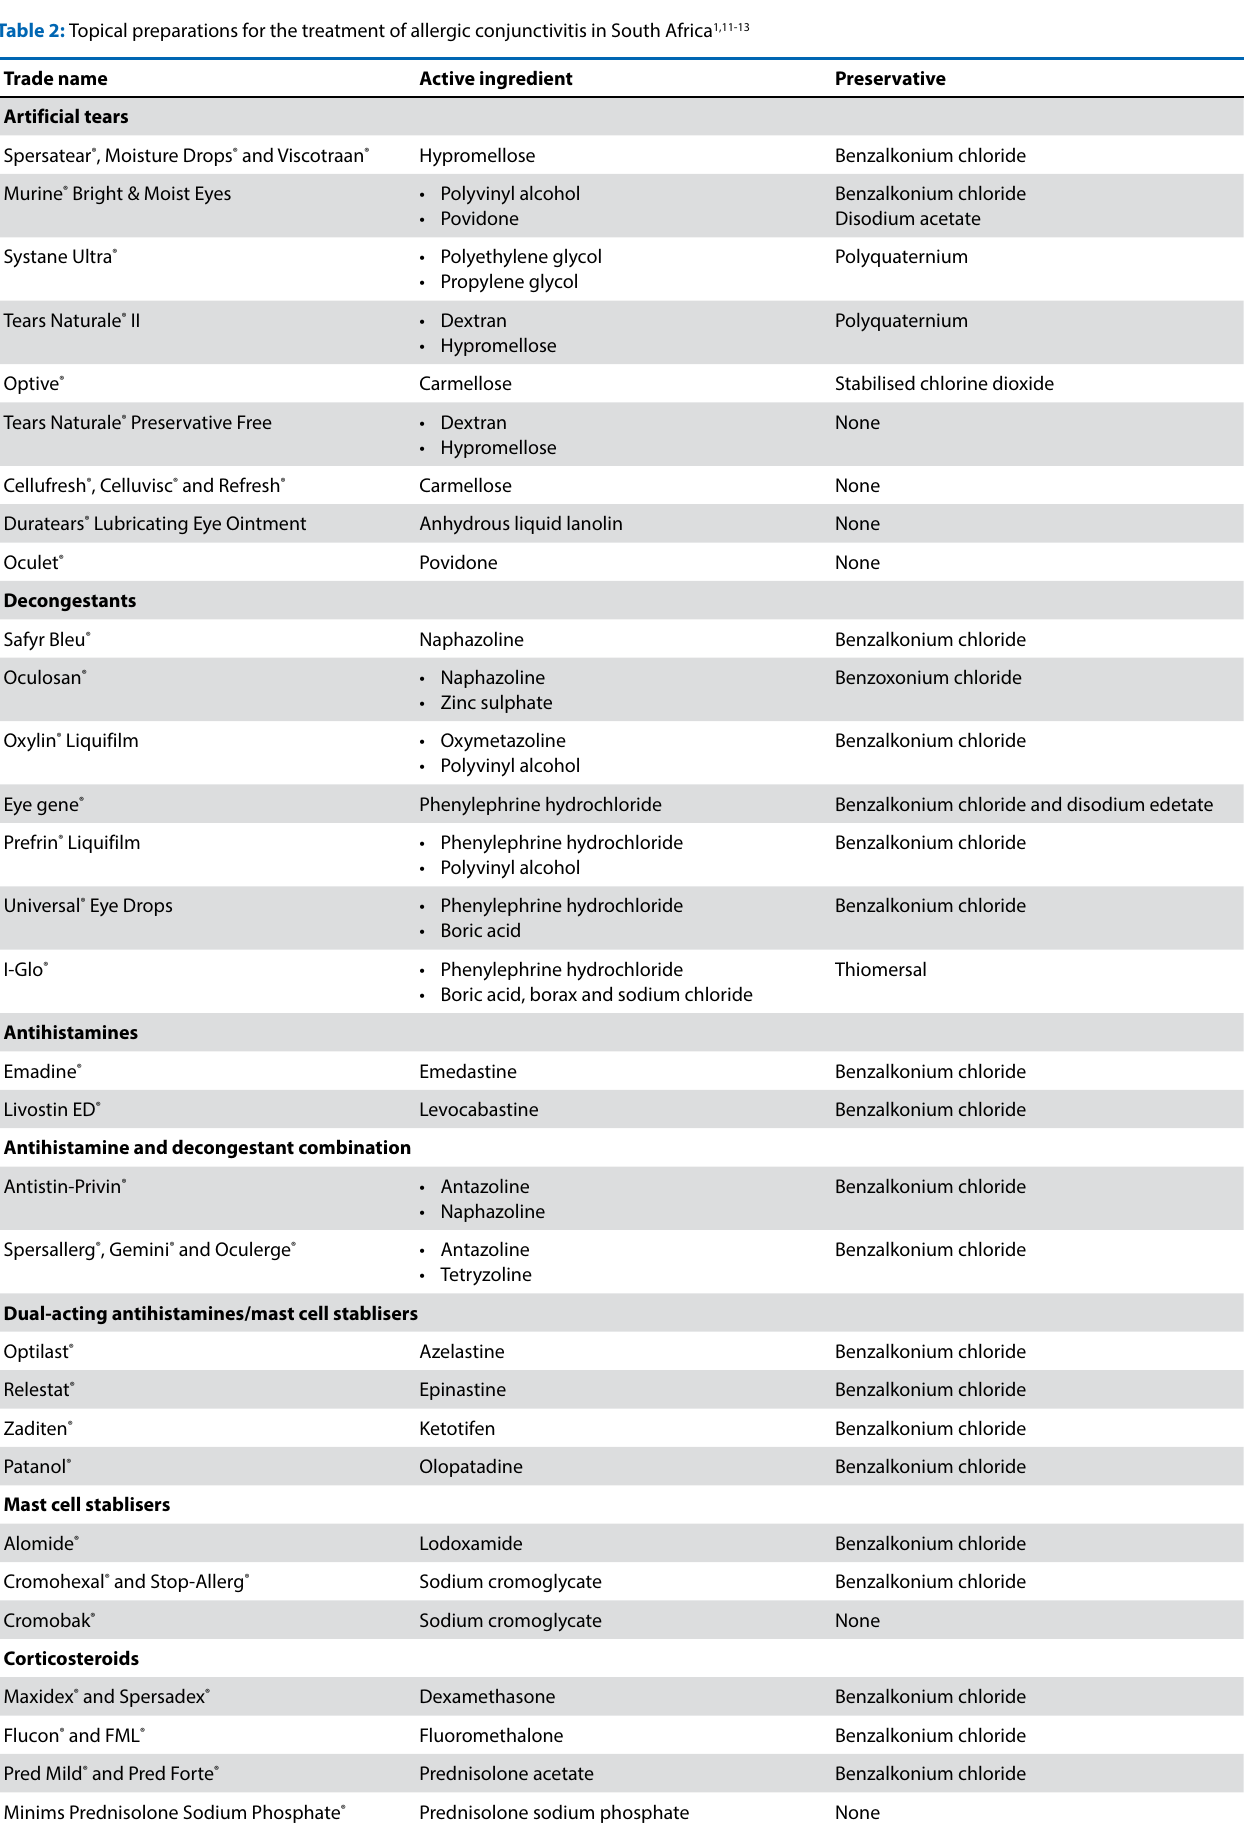
Table 2: Topical preparations for the treatment of allergic conjunctivitis in South Africa 1,11-13